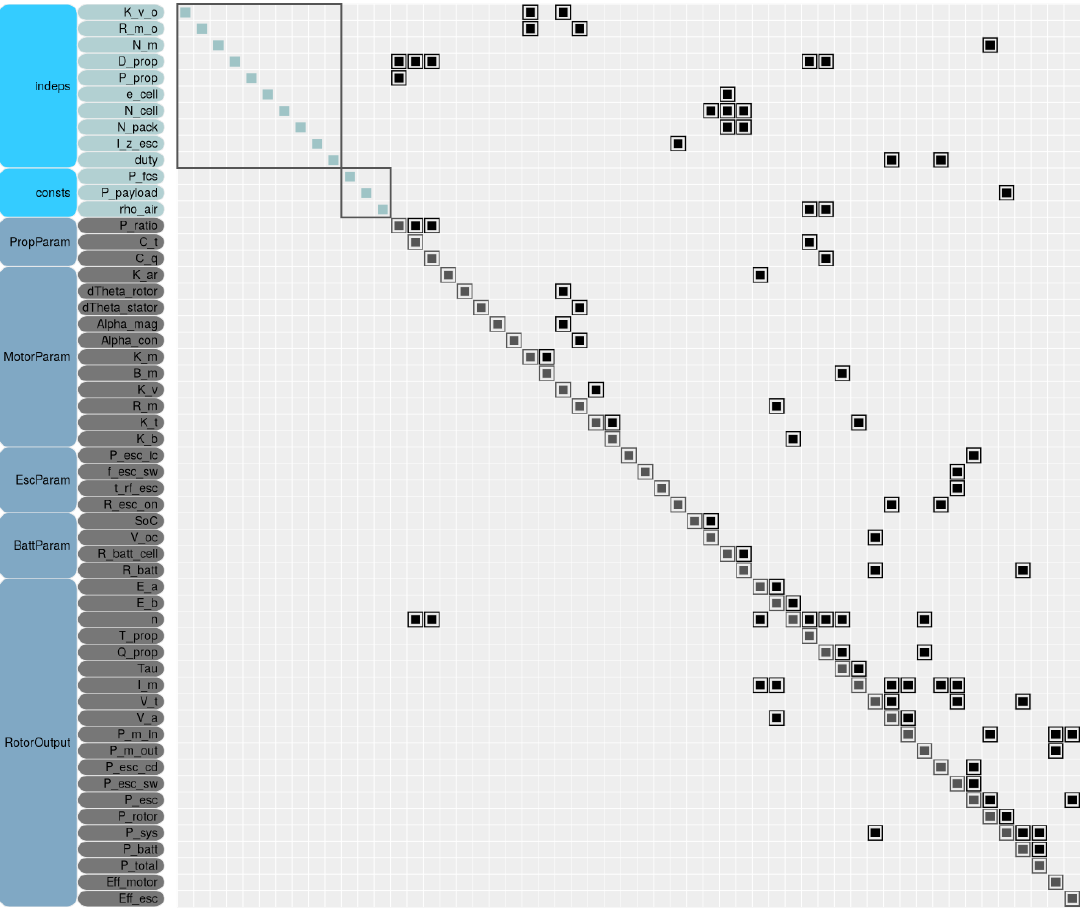
Figure 15. N 2 diagram for the proposed performance calculation process of the electric propulsion system model.